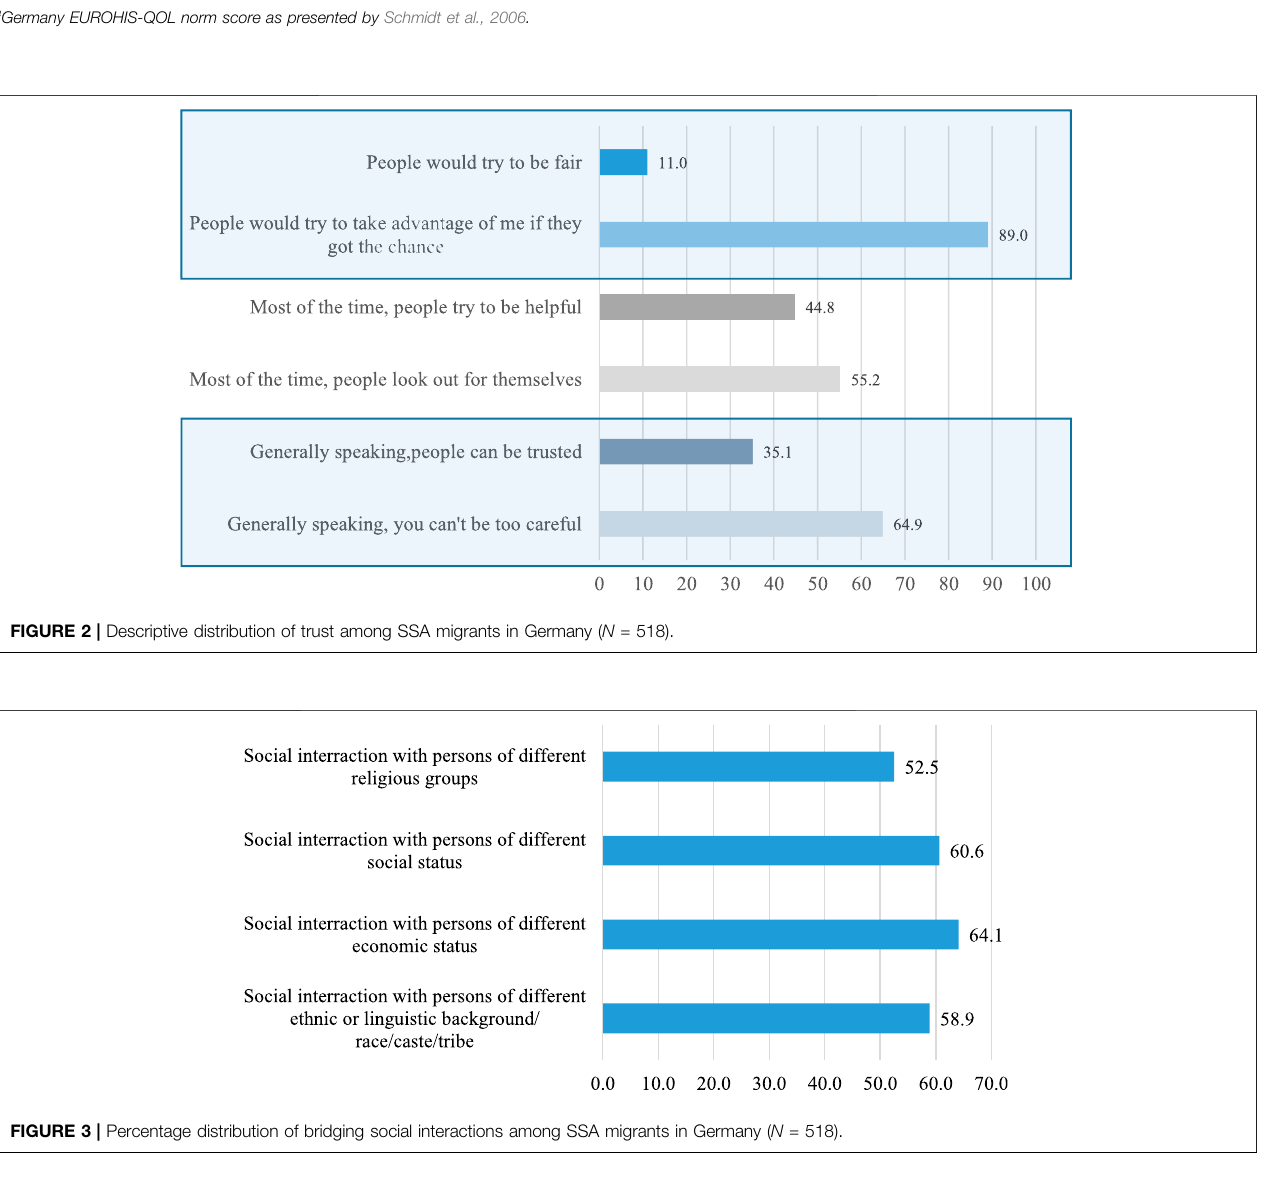
Frontiers in Sociology |